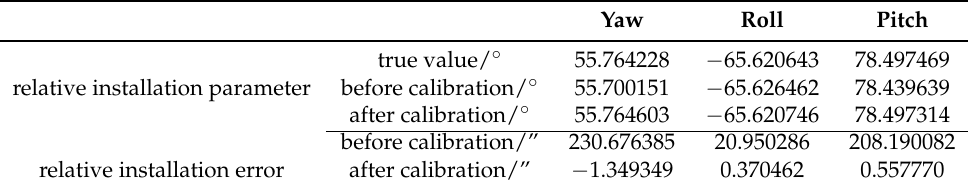
Table 4. The relative installation error from star sensor C to star sensor B.